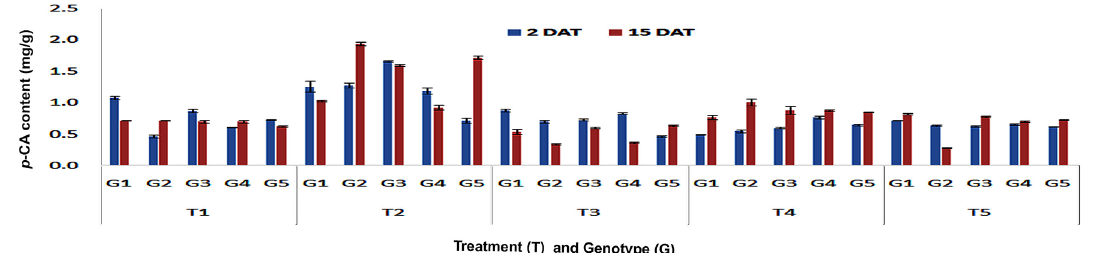
Figure 2. Changes in p -CA content in leaf tissues of maize genotypes to induced treatments in short (2 DAT) and long (15 DAT) term responses on the imposition of treatments at V6 stage (G1: DMRE 63; G2: CM 500; G3: WNZ Exoticpool; G4: CM 202; G5: BML 6; T 1 : Control; T 2 : PSB feeding; T 3 : Wounding; T 4 : Combination of wounding plus regurgitation; T 5 : Exposure to methyl